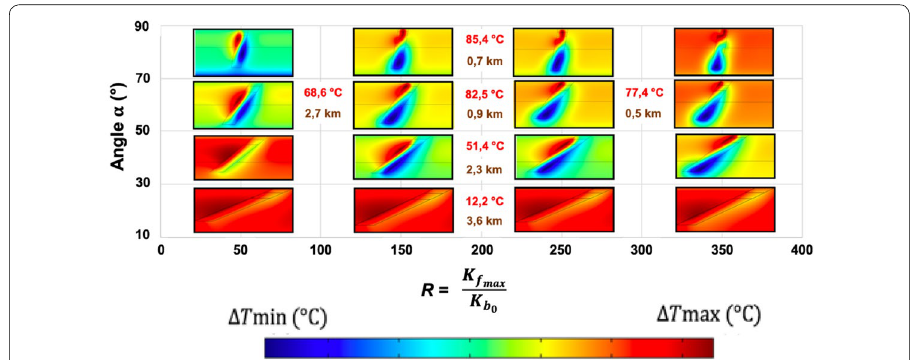
Fig. 11 Graphical representation of all numerical models of temperature anomalies on the theoretical fault zone performed ( n 216). The values of positive thermal anomalies are shown in red. Their depths are = represented in